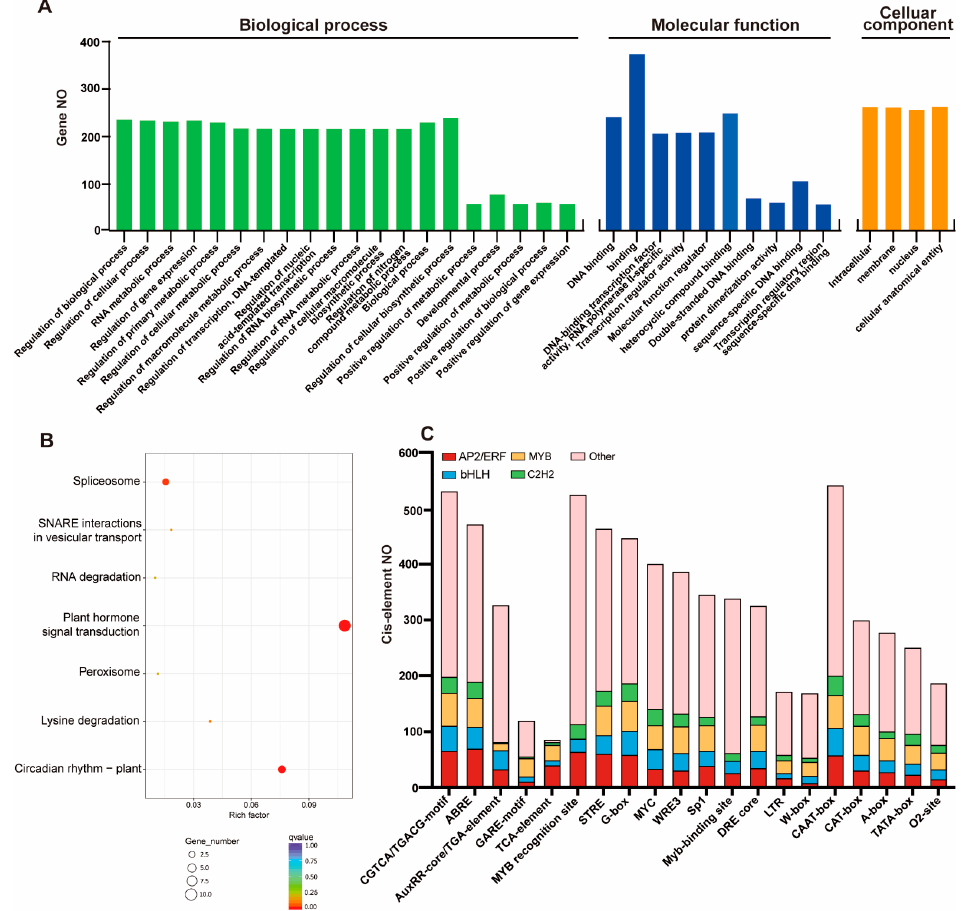
Figure 3. Molecular functional analysis of TF families in S. caninervis . ( A ) Gene ontology (GO) analysis of TF protein members. ( B ) KEGG pathway analysis of TF members. ( C ) Prediction of cis -element analysis of TF gene promoter regions.